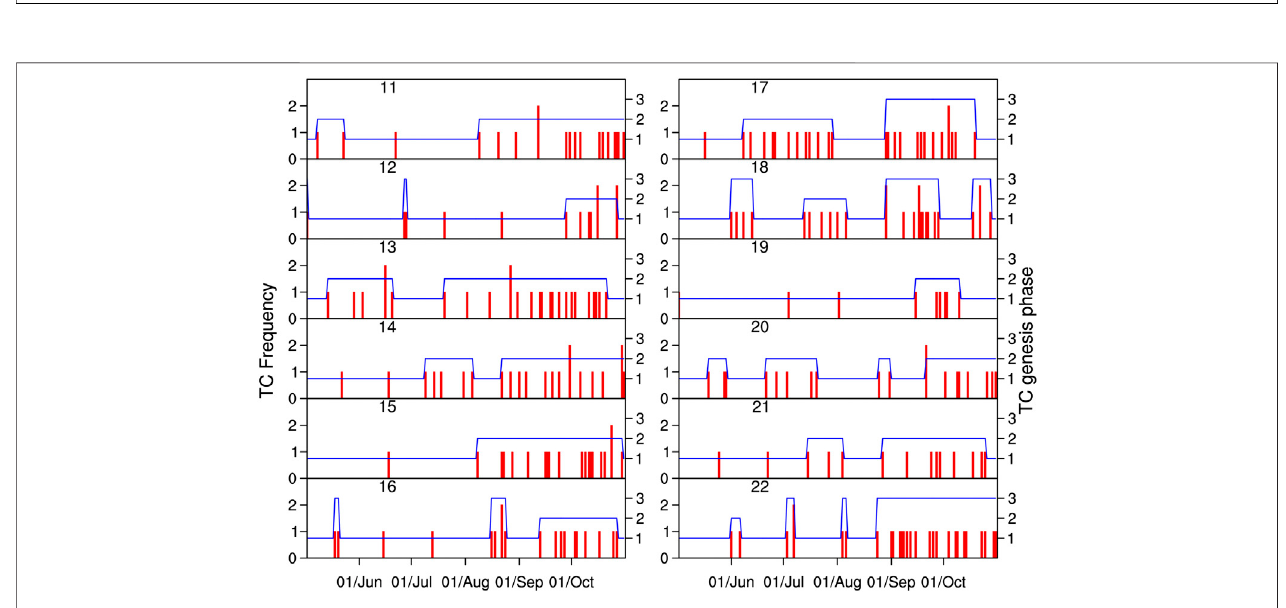
FIGURE 5 | Same as in Figure 1 , but for the 12-year control-run experiment.